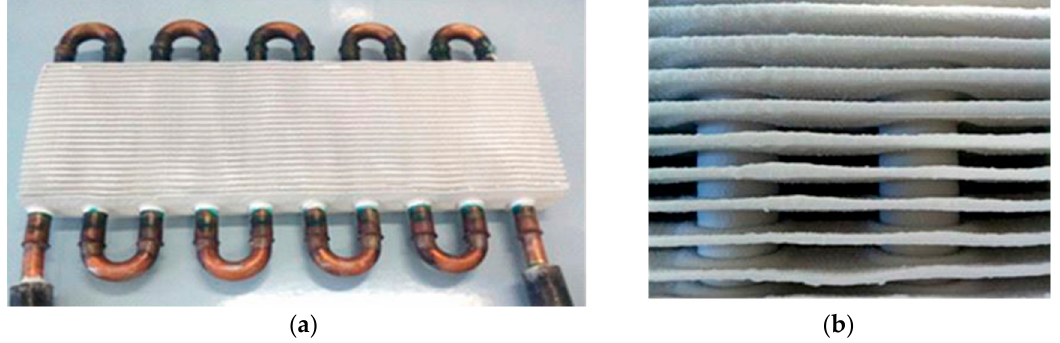
Figure 7. ( a ) a coated heat exchanger, ( b ) detail of coated fins.